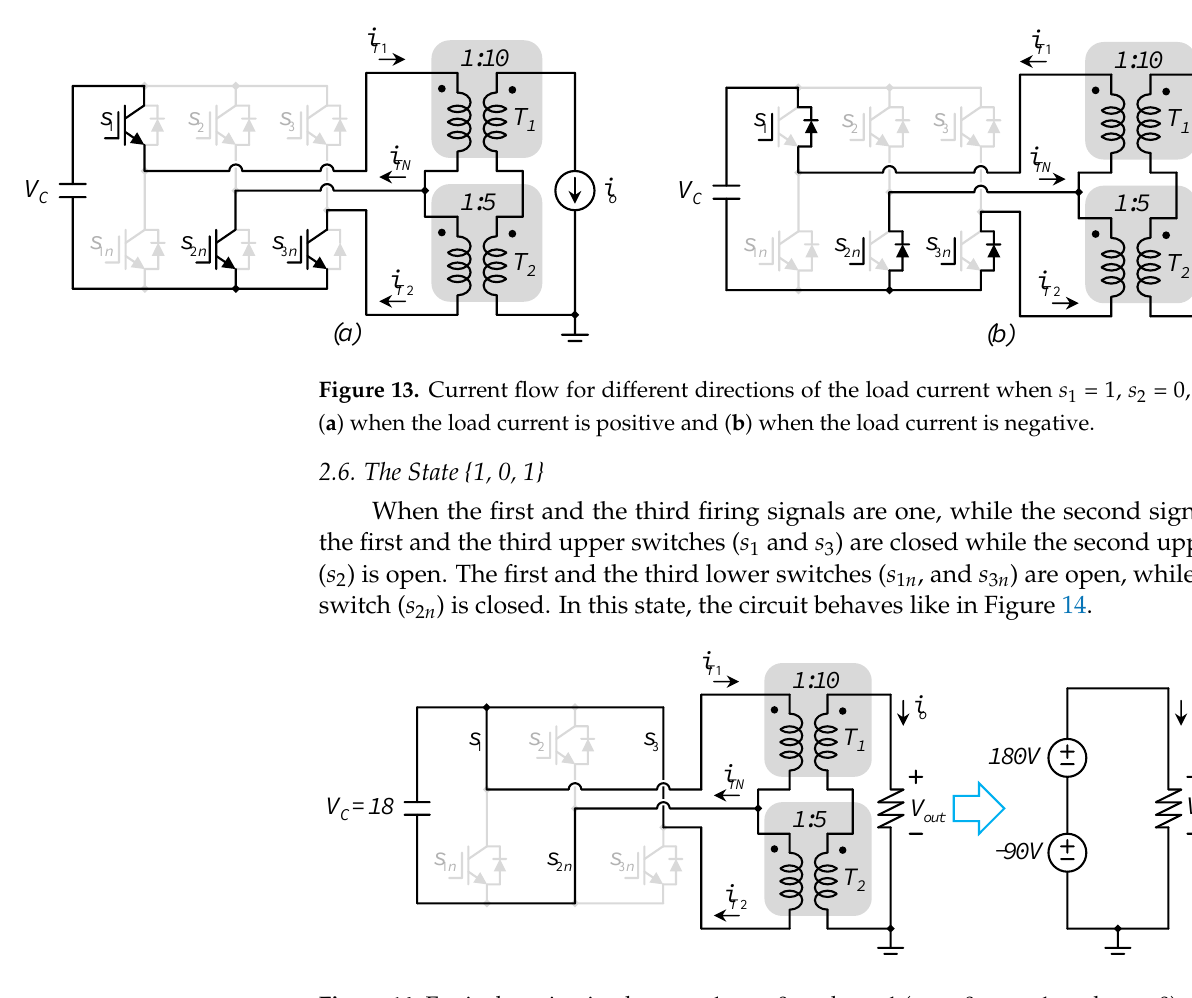
state, the inverter provides an output of 90